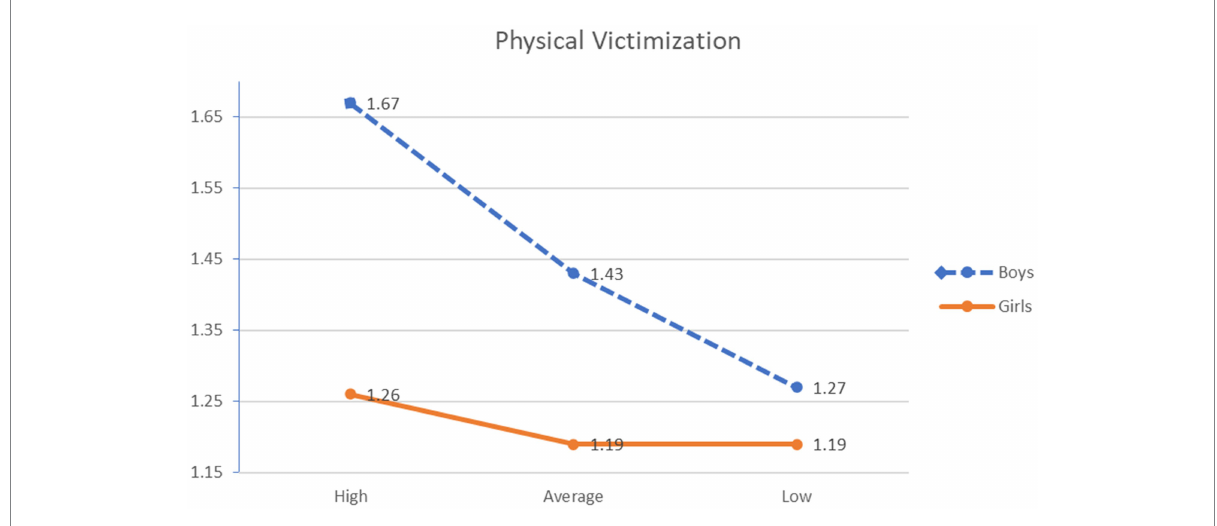
FIGURE 1 Interaction effect feeling of guilt × gender and physical victimization.